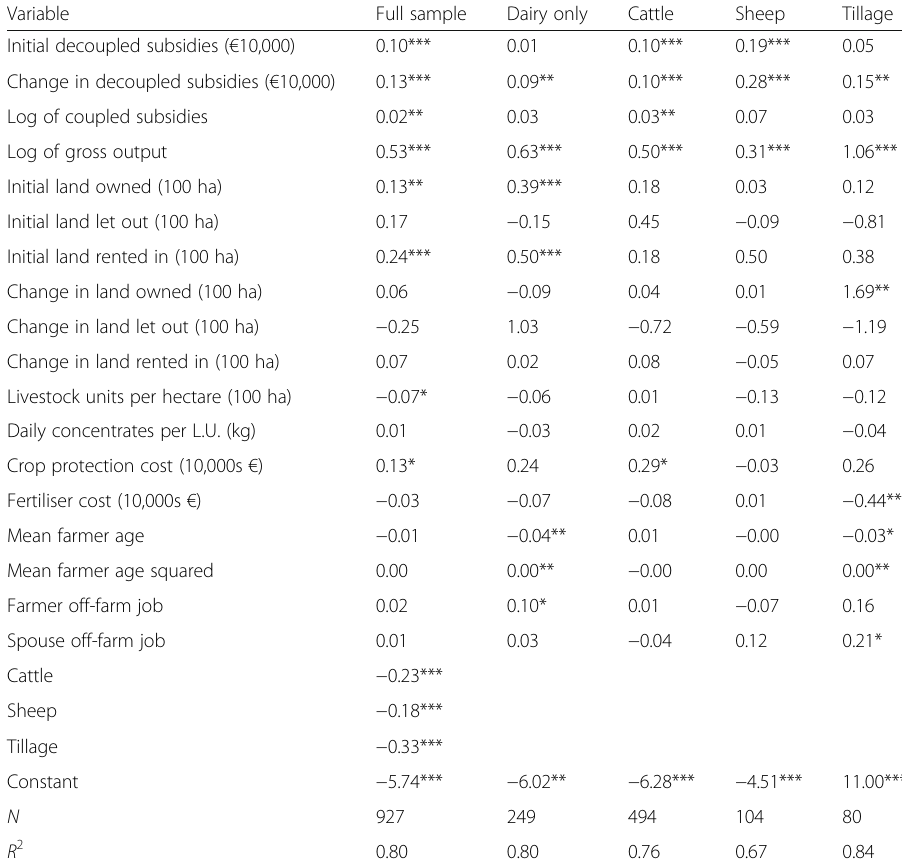
Table 2 Standard deviation of market income on Irish farms Variable Full sample Dairy only Cattle Sheep Tillage Initial decoupled subsidies ( € 10,000)